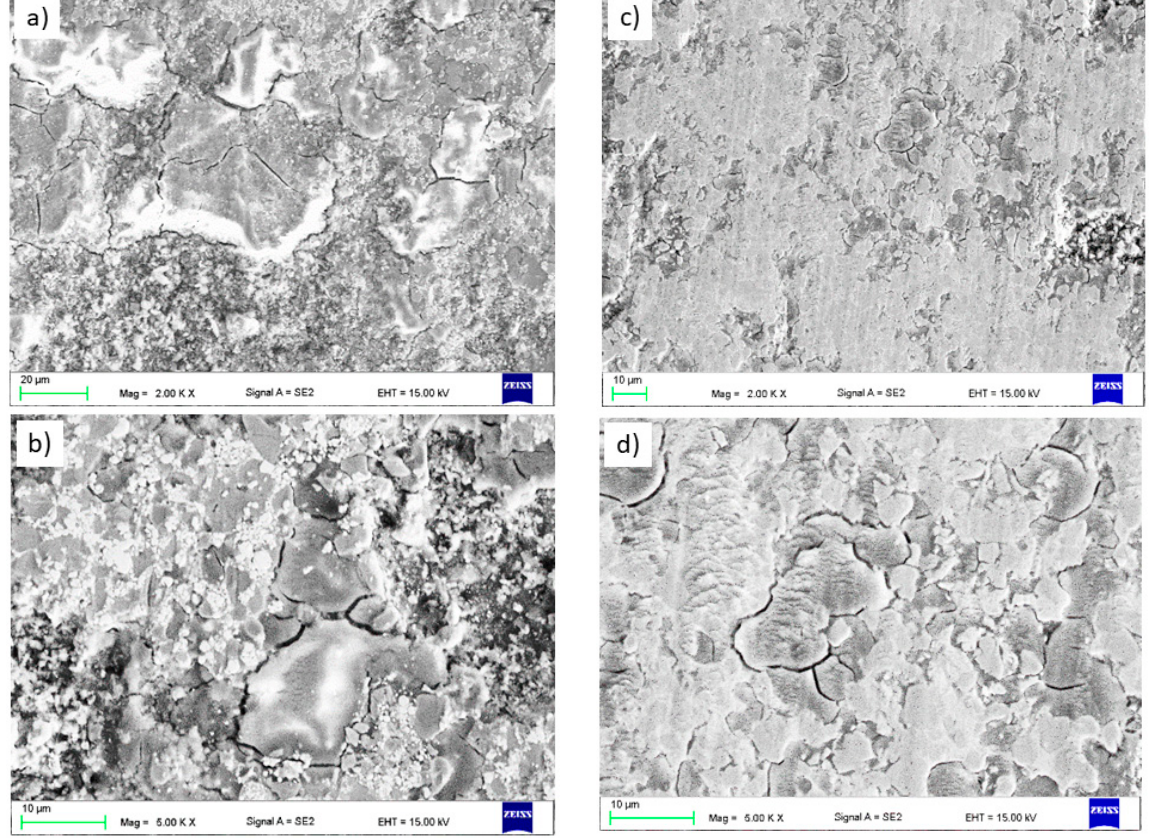
Figure 9. Details of wear tracks of manufactured coatings: ( a , b ) for the WC coating and ( c , d ) for the CrC coating, SEM.